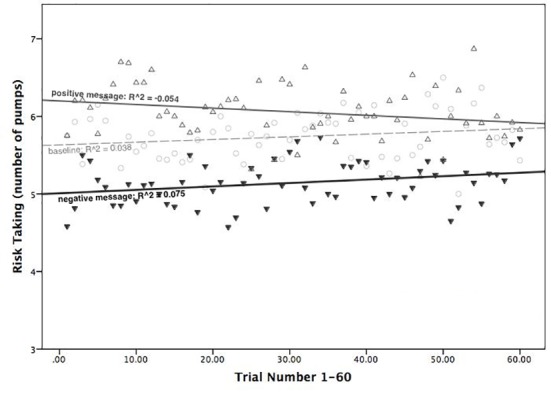
Risk taking as a function of trial number 1–60, for each block of trials.Note: middle dashed line and circles indicate performance in the baseline; bottom bold black line and down-pointing arrows denote performance in the negative message block; top solid grey line and up-pointing arrows denote performance in the positive message block. No significant changes in risk taking across 60 trials were found in the two experimental blocks.